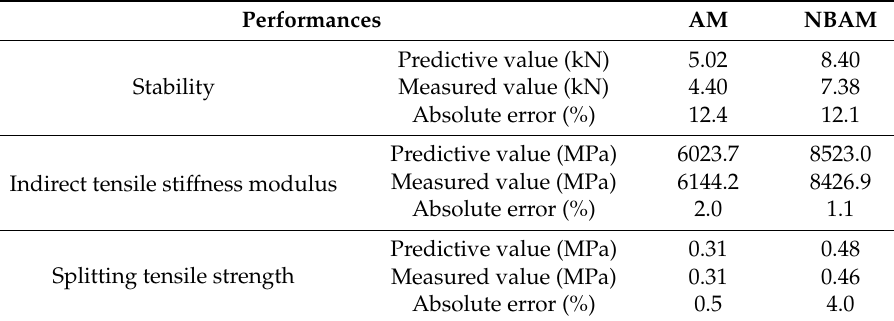
Table 7. Twentieth cycle prediction data of asphalt mixture.